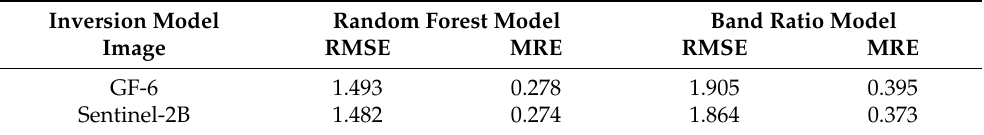
Table 4. ‘red green blue’ band water depth inversion